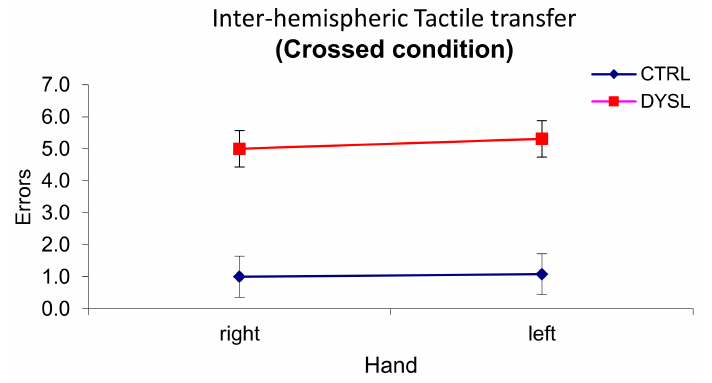
Figure 2. Results of the interhemispheric transfer of tactile information